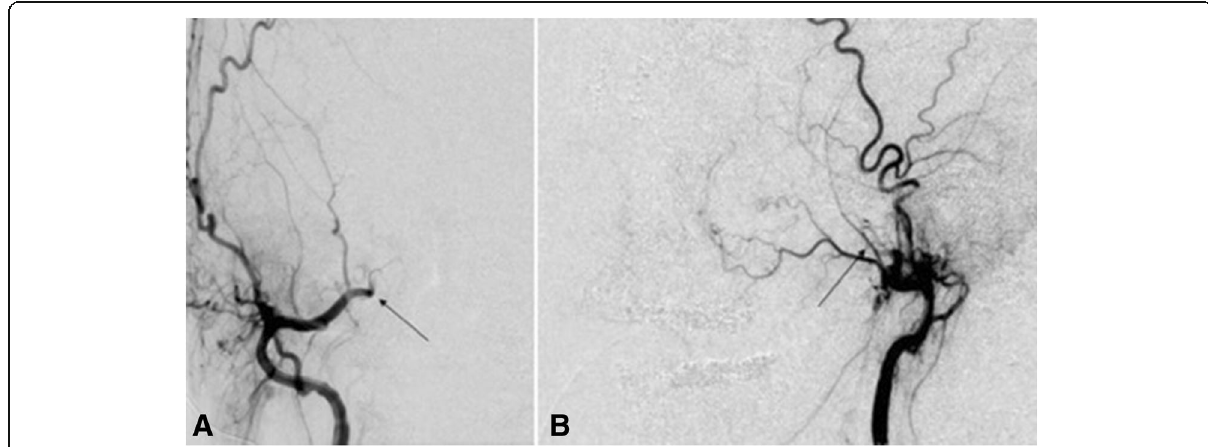
Fig. 4 A and B AP and lateral right internal maxillary angiogram after embolization of the distal branches of the internal maxillary artery with 300 – 500 μ m embospheres and gelfoam pledgets shows truncation of the distal internal maxillary artery (small black arrow) with no vascular